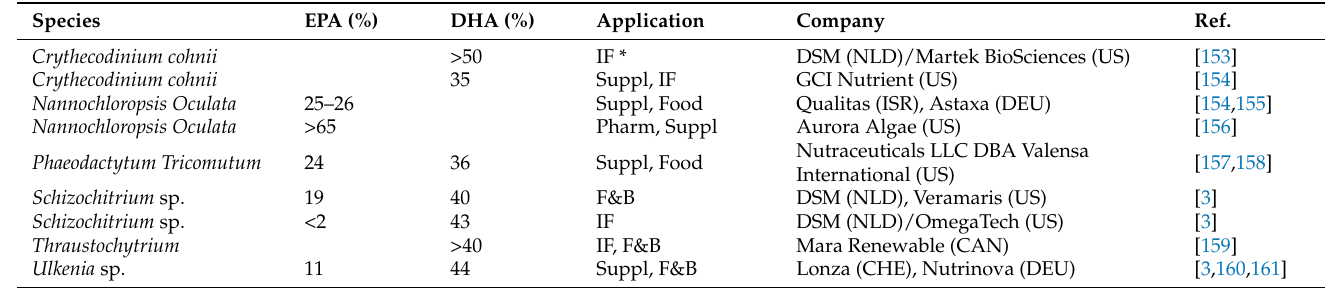
Table 2. Microalgae species/strains used for n-3 PUFA production at large scales.